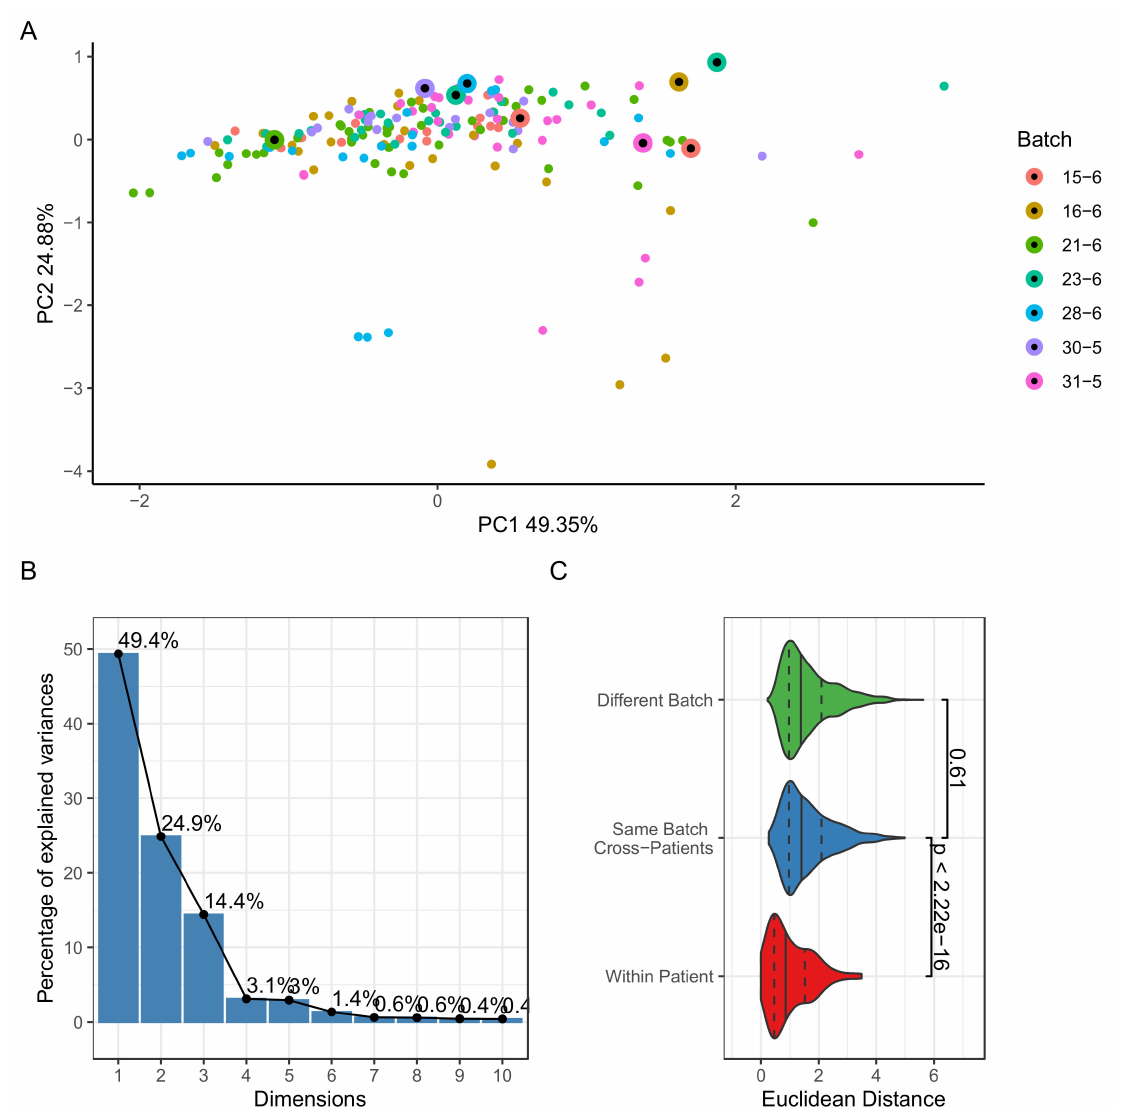
Figure 2. Assessment of technical variability and batch effects. ( A ) Principal component analysis showing the first two components colored by batch. Quality control samples are marked with black dots. ( B ) Scree plot showing variance explained by top 10 principal components. ( C ) Violin plots showing the distribution of Euclidean distances between spectra from the same patient, across patients and batches. The vertical lines represent the first, second, and third quartiles. Wilcoxon Rank sum p values are shown between